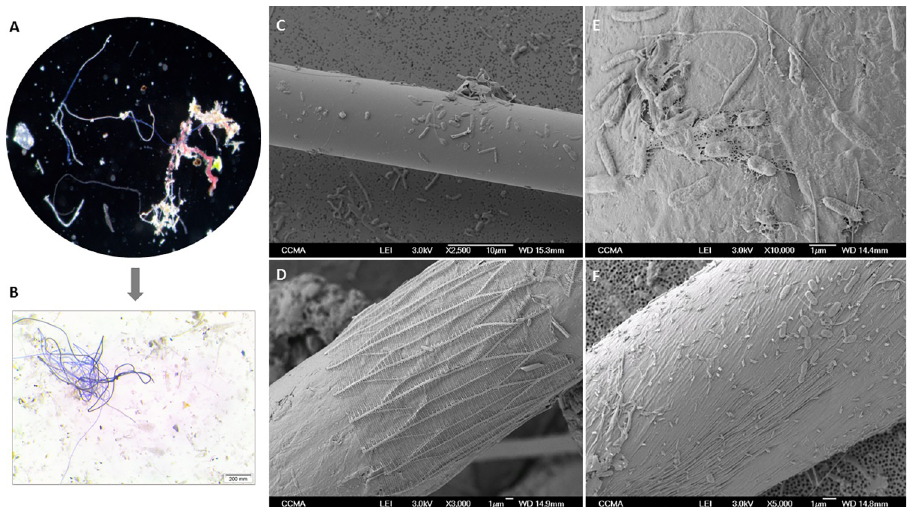
Fig 2. Optical microscopy of floating fibers sampled at the Mediterranean Sea (A, B), and Scanning Electron Microscopy (SEM) images of their attached bacteria, with elongated and rounded cells, as well as Extracellular Polymeric Substances (EPS) (C-F).